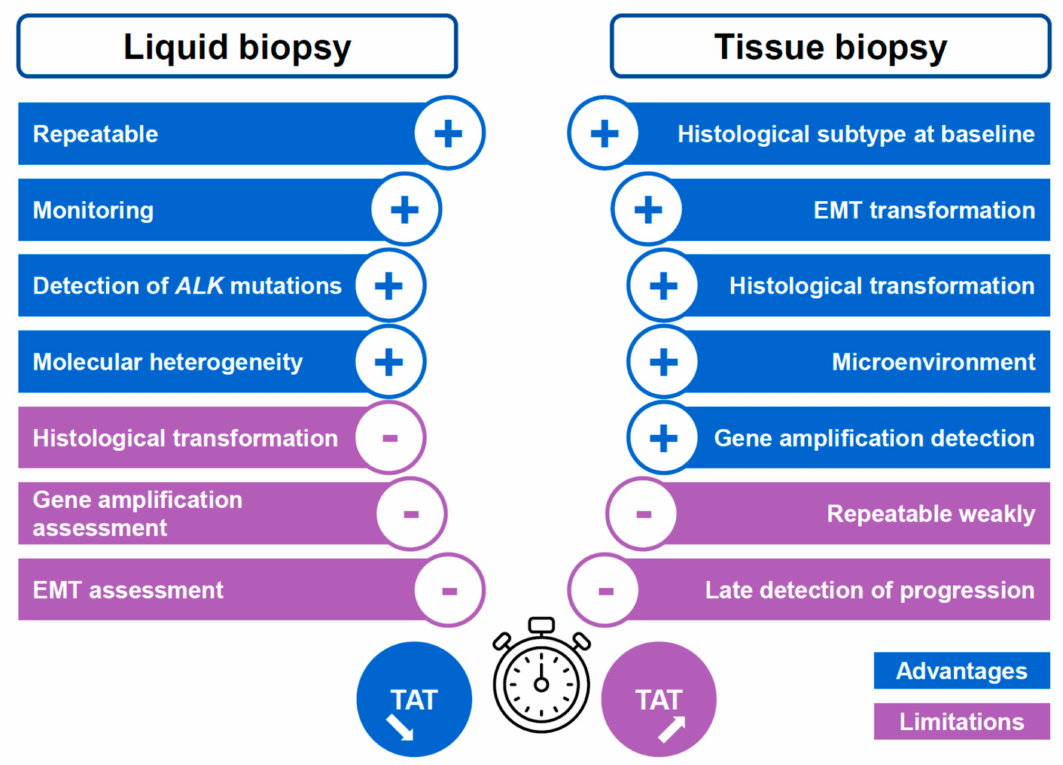
Figure 2. Main advantages and limitations of a liquid biopsy and a tissue biopsy for ALK -positive patients. TAT, turnaround